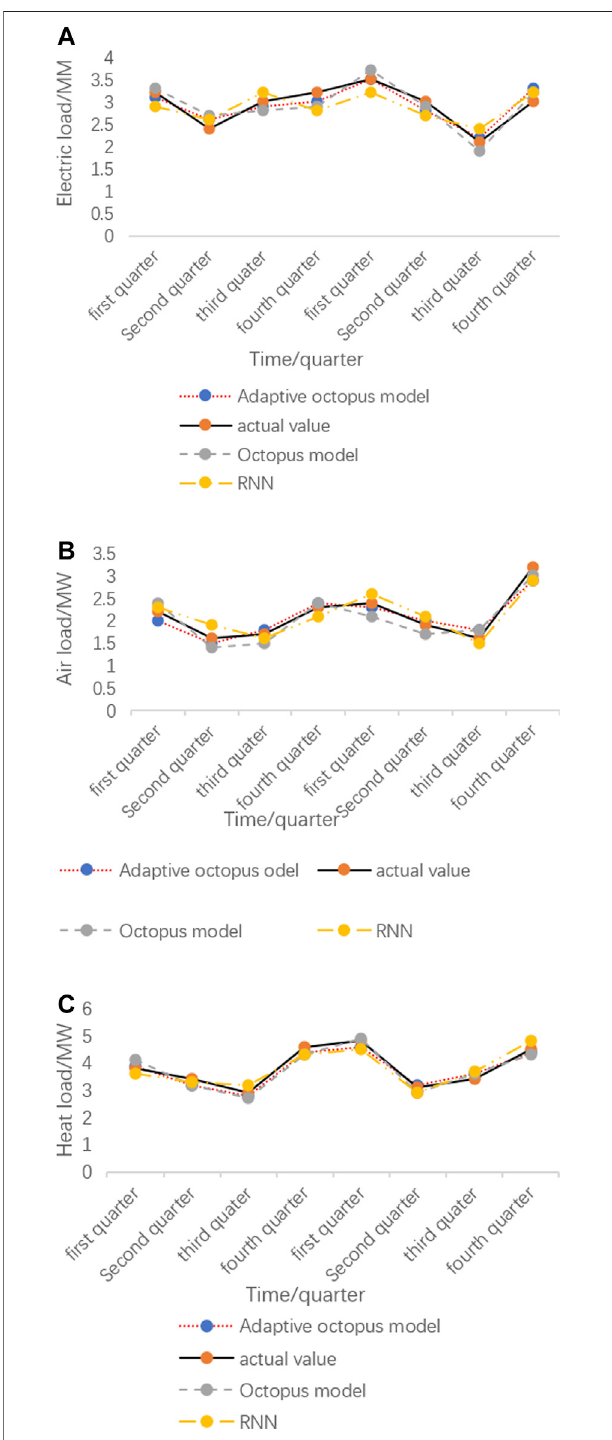
FIGURE 6 | Comprehensive energy long-term forecast